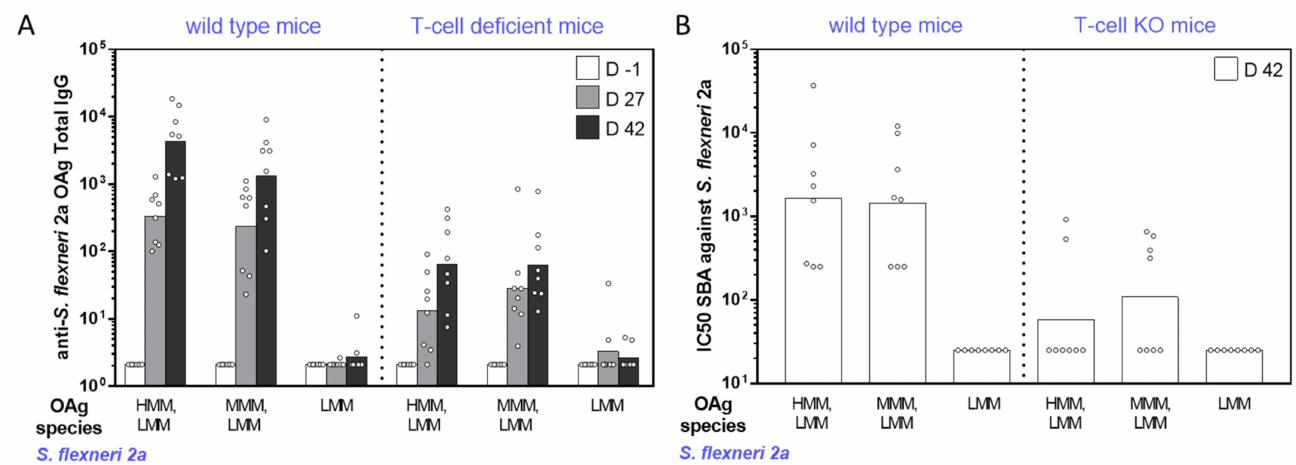
Figure 3. Immunogenicity in mice of S. flexneri 2a GMMA differing for sugar length. Eight wild-type (CD1) and T- cell-deficient mice (nude CD1) per group were subcutaneously immunized on days 0 and 28, with 0.5 µ g OAg dose. ( A ) Summary graphs of anti-OAg specific IgG reporting individual antibody levels (dots) and geometric mean with 95% confidence interval (bars). ( B ) Summary graph of SBA titers against S. flexneri 2a reporting individual IC50 levels (dots) and geometric mean (bars).